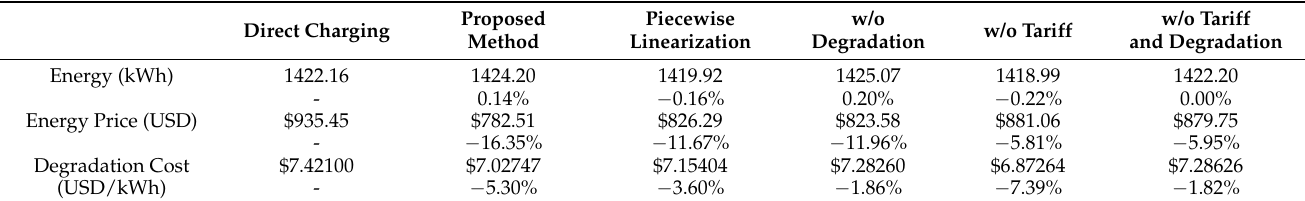
Table 4. Results Table 4. Results comparison.